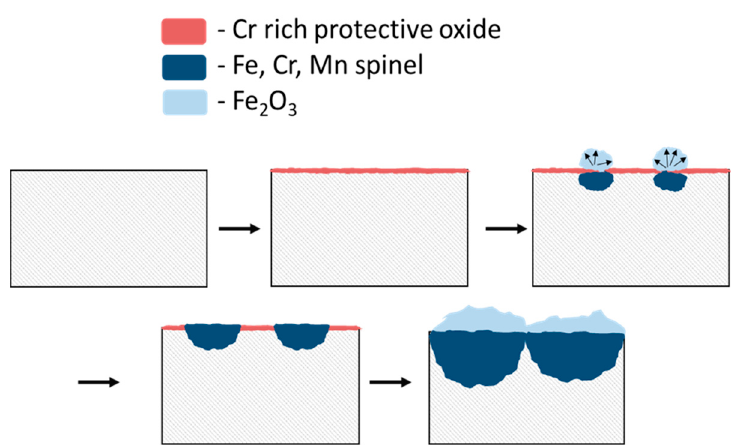
Figure 18. Proposed mechanism for steam oxidation of HT347HFG at 700 °C.